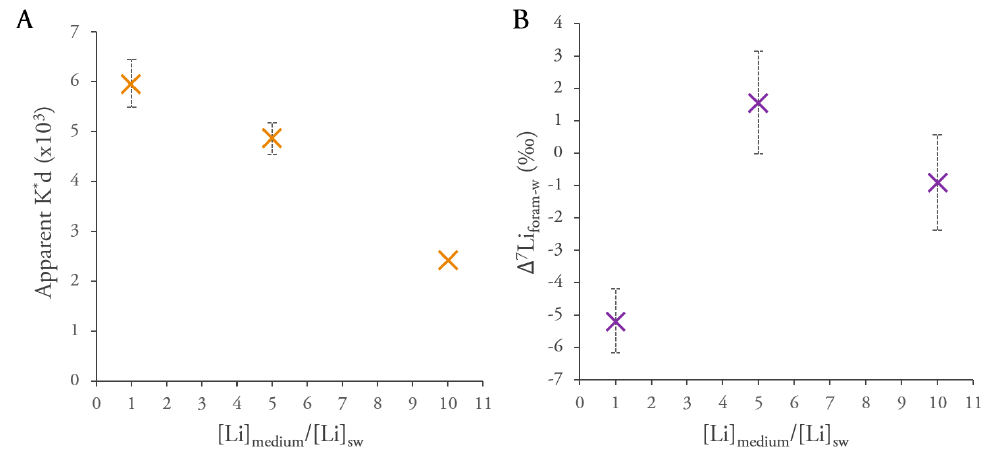
Figure 3. Effect of 1, 5, and 10 × Li-enriched seawater on ( A ) apparent partition coefficient K*d and ( B ) the Li isotopic fractionation factor between foraminiferal calcite and seawater ( Δ 7 Li foram-w ). Values from the control treatments were used. The error bars represent the external error (2 σ ).